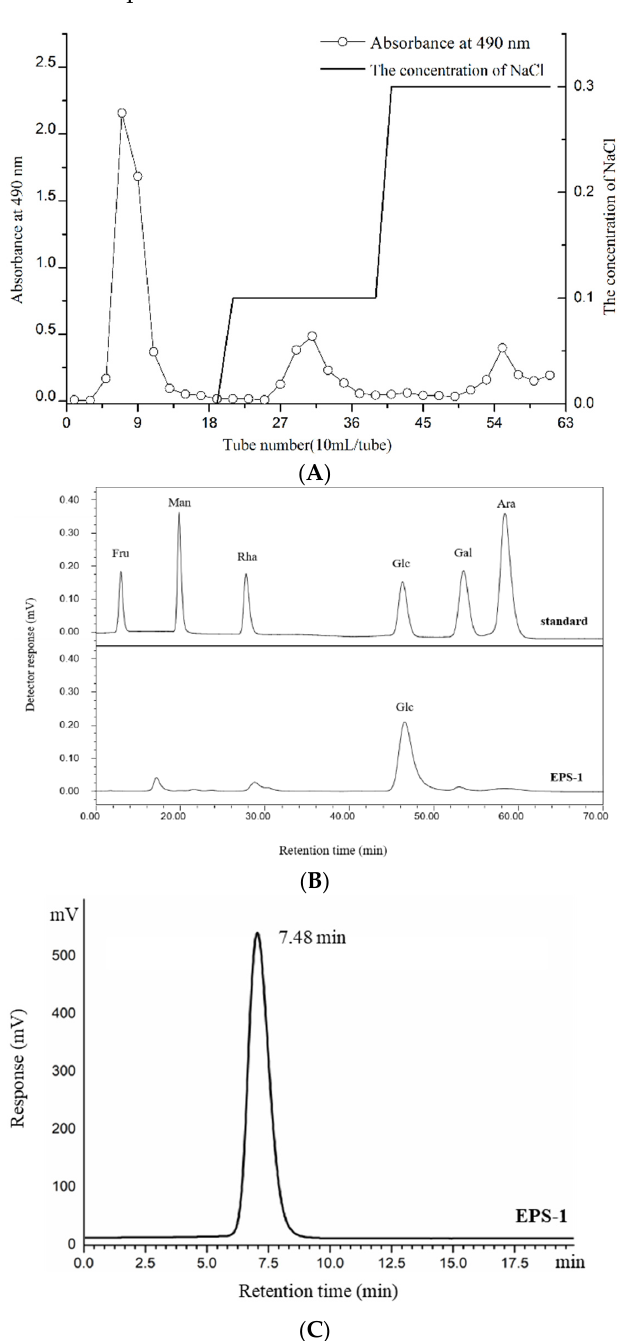
Figure 2. DEAE − cellulose − 52 anion exchange chromatogram ( A ), monosaccharide composition chromatogram ( B ) and HPSEC chromatogram of relative Mw distribution ( C ) of EPS − 1 from Lc. citreum 1.2461.